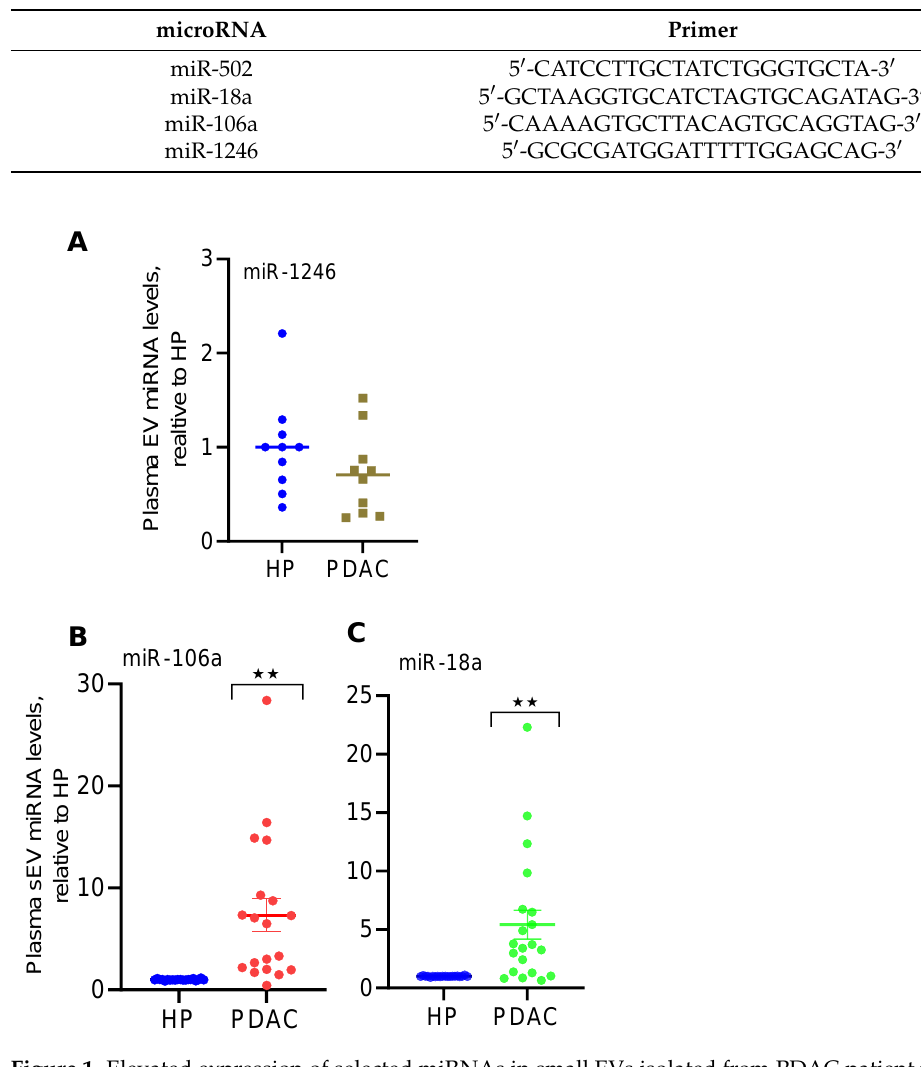
Figure 1. Elevated expression of selected miRNAs in small EVs isolated from PDAC patient plasma. Small EVs were isolated from plasma (250 µ L each) of patients with early-stage PDAC and age- and gender-matched healthy subjects (HP). miRNA expression was analyzed by qRT-PCR. Expression of miR-1246 (( A ), n = 10), miR-106a (( B ), n = 19), and miR-18a (( C ), n = 20) is shown. ** p < 0.01, paired Student’s t -test. Table 3. Primers used for real-time PCR.